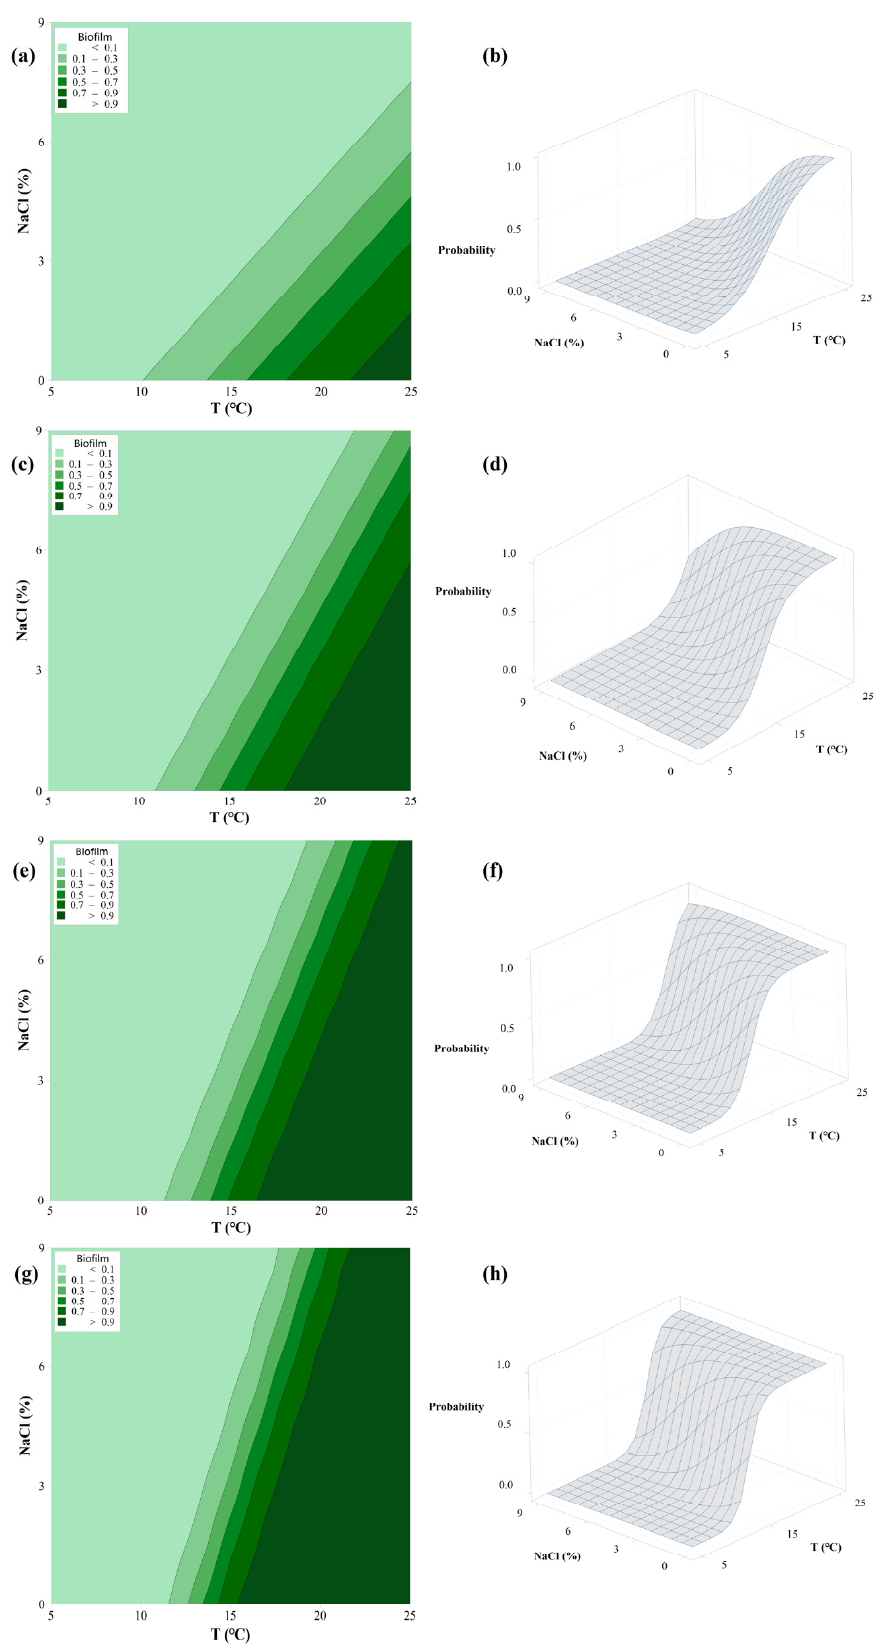
Figure 2. Contour maps and surface plots of biofilm formation probability by L. monocytogenes ST9 as affected by T and NaCl at pH 5.0 ( a , b ); pH 6.0 ( c , d ); pH 7.0 ( e , f ); and pH 8.0 ( g , h ).